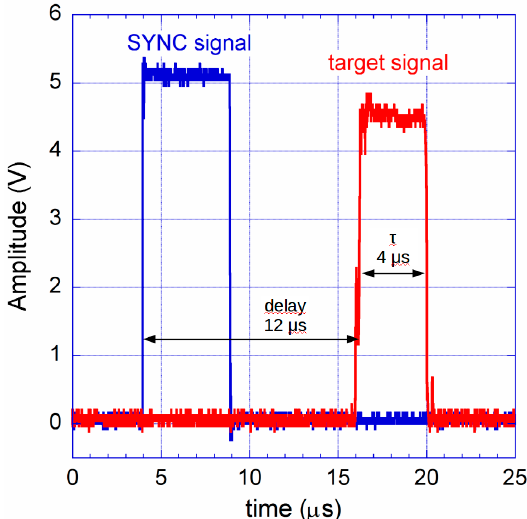
Figure 1. Example of an electron pulse (red curve, 4 µs wide) generated by a LINAC apparatus and impinging onto a heavy metal target to produce an equivalent X-ray pulse. The blue curve shows the produced sync signal 12 µs before the target electrons’ current-pulse rising edge.